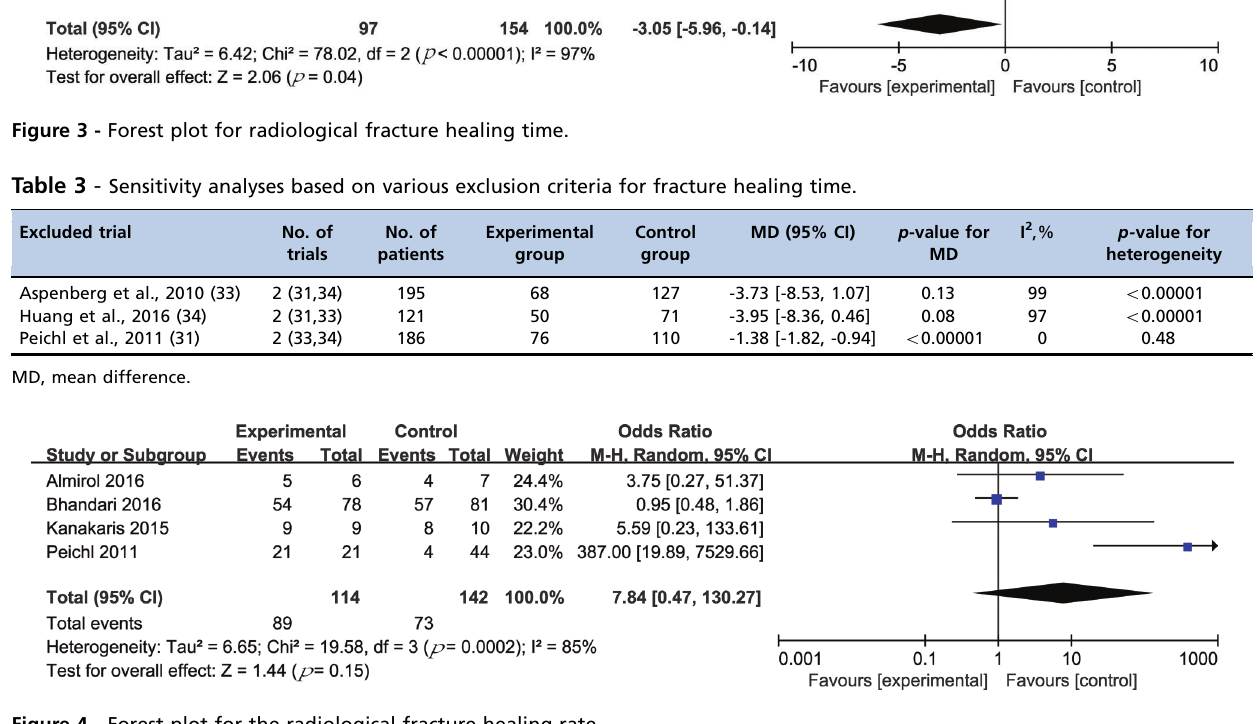
Figure 4 - Forest plot for the radiological fracture healing rate. Table 4 - Sensitivity analyses based on various exclusion criteria for fracture healing rate. Excluded trial